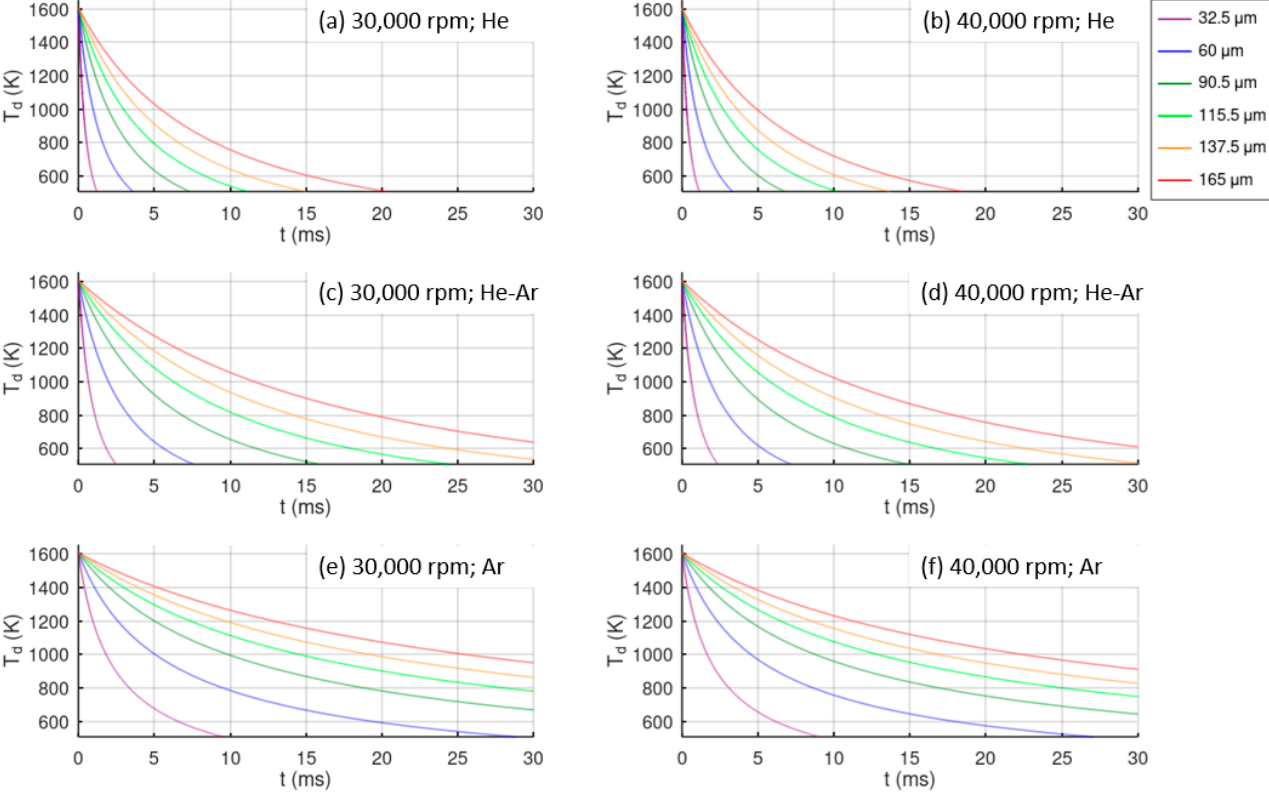
Figure 7. Temperature variation in centrifugally atomized droplets of different sizes in different atomization conditions of disk velocity and gas atmosphere .